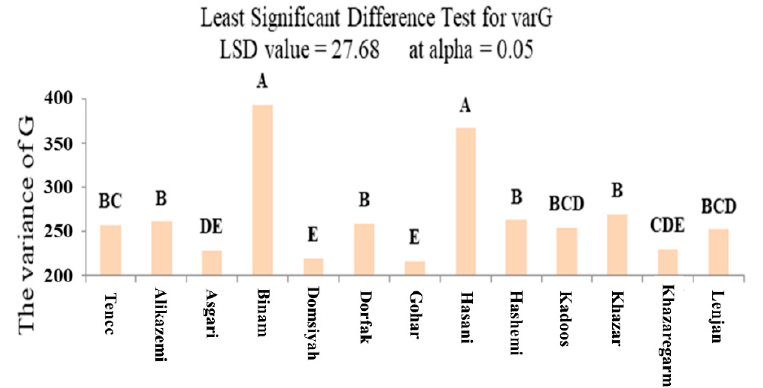
Figure 9. Comparison of the standard deviation of B values of paddy cultivars.